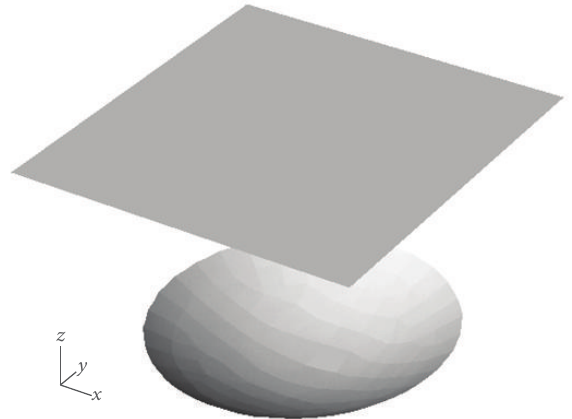
Figure 16: Single reflector with observation surface.